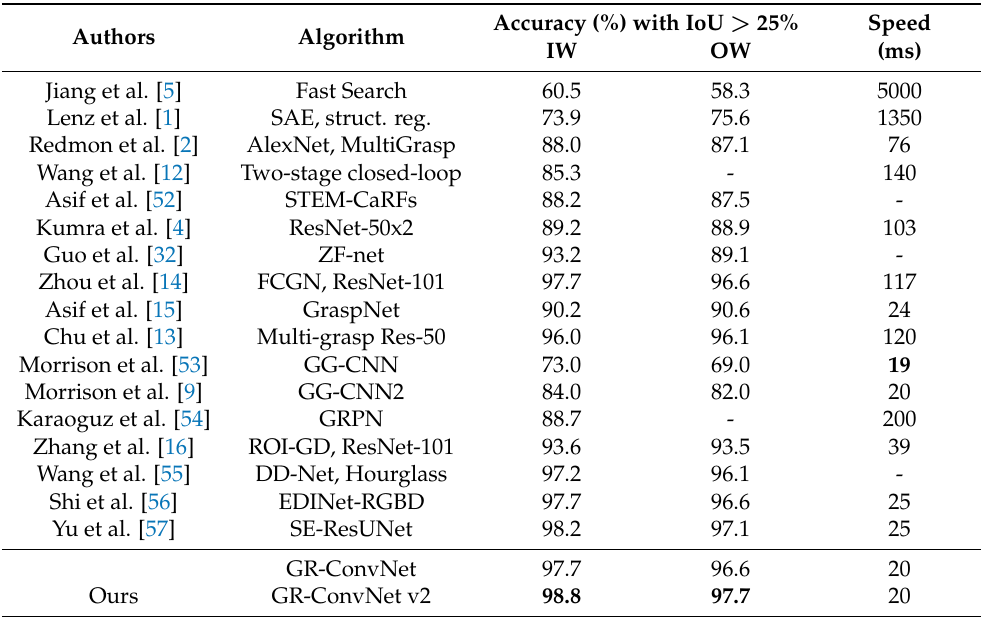
Table 3. Comparative results on Cornell grasping